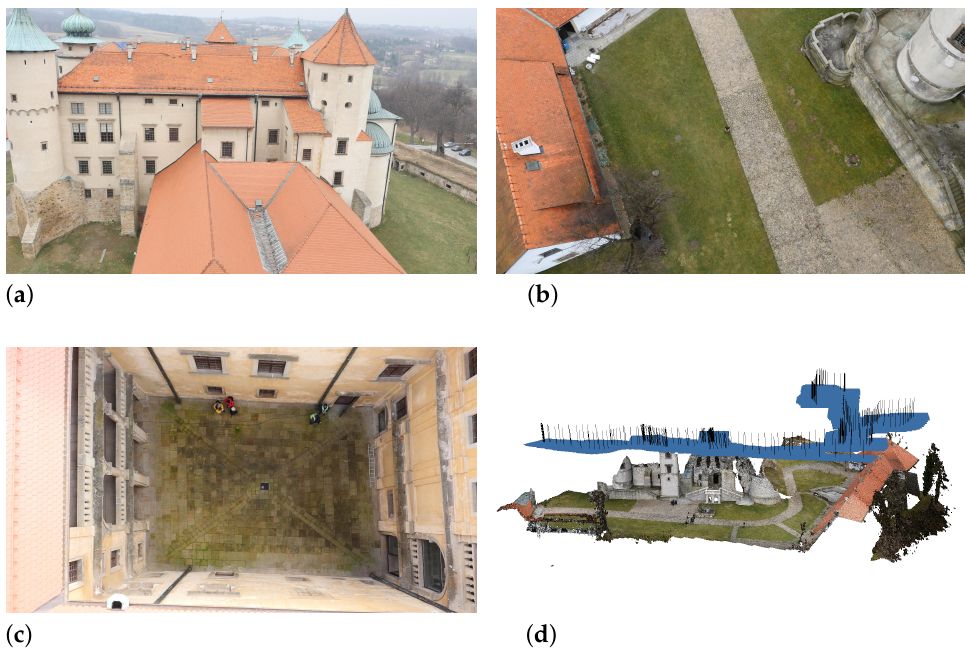
Figure 5. Examples of photographs for individual aerial photography collections ( a – c ); estimation of image locations for a sample set of aerial photography in orthogonal projection ( d